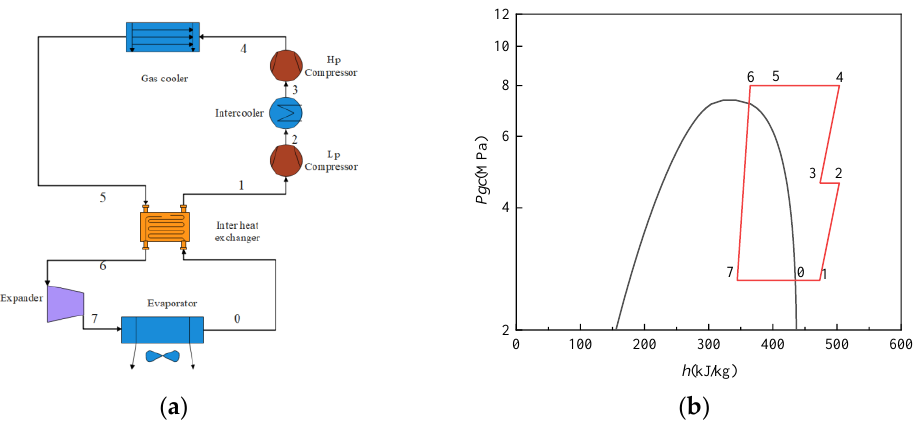
Figure 1. Schematic diagram of internal heat exchanger on two-stage compression trans-critical CO 2 refrigeration cycle combined with expander and intercooling. ( a ) System flow chart. ( b ) System P - h